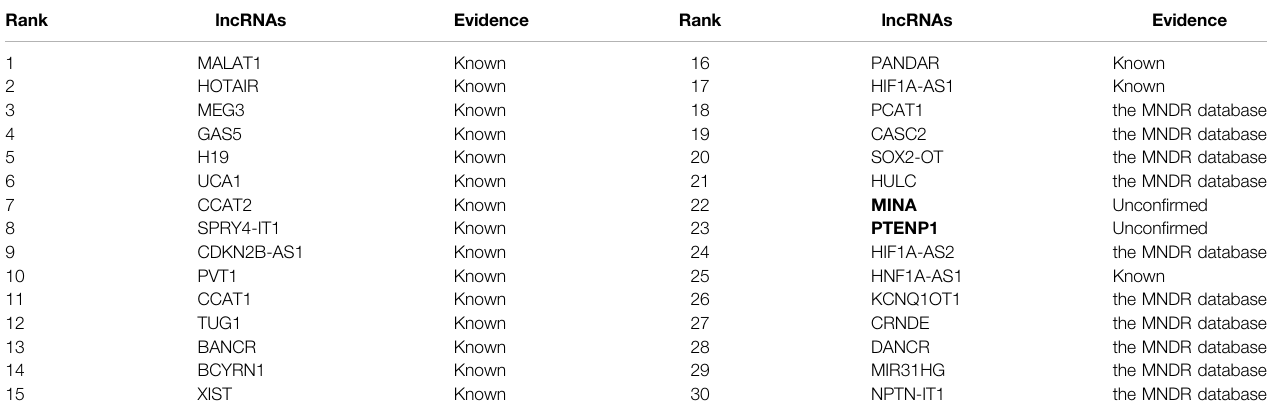
TABLE 3 | Inferred top 30 lncRNAs associated with NSCLC.